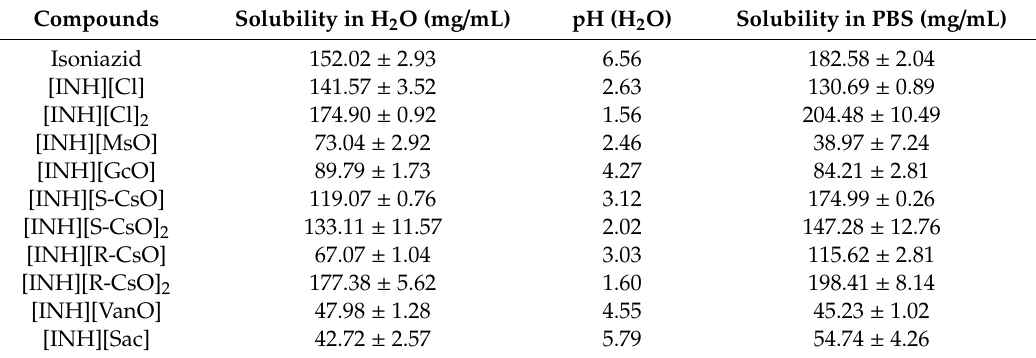
Table 2. Solubility of isoniazid and respective organic salts, at 37 ◦ C, in water and Phosphate bu ff ered saline